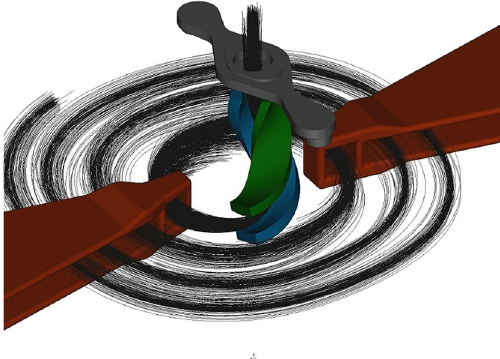
FIG. 1. Schematic of a spiral inflector with particle trajectories from an OPAL simulation. The beam enters axially (from the top) through an aperture (grey) and is bent into the midplane by a combination of the electrostatic field generated by the spiral electrodes (green and blue, voltage typically symmetric at þ V spiral and − V spiral ) and the cyclotron ’ s main magnetic field. Then it is accelerated by the two Dees (copper, Dummy-Dees not shown). Color